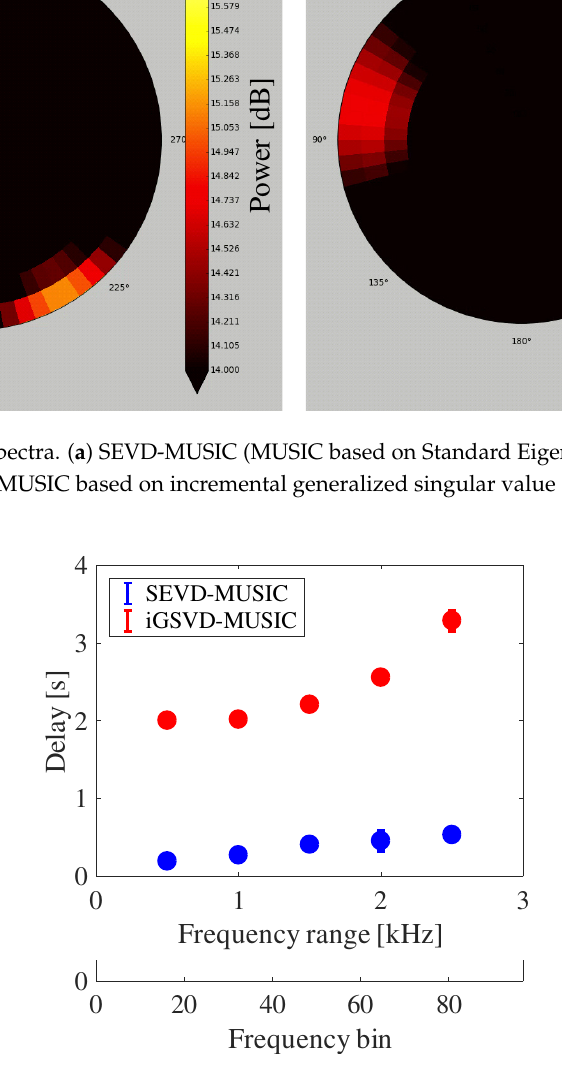
Figure 12. Time delay of the